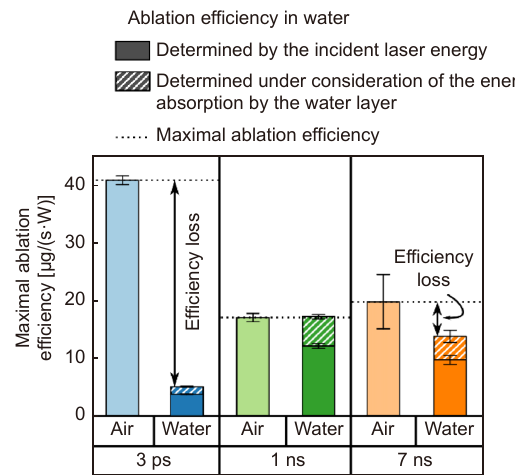
Fig. 2 | Maximal ablation efficiency for the ablation of gold in air (light-colored, solid bars) and water (dark-colored bars) for lasers of 3 ps (blue, ~2 J/cm² and 100 μJ/pulse), 1 ns (green, ~8 J/cm² and 130 μJ/pulse), and 7 ns (orange, ~13 J/cm² and 400 μJ) pulse dura- tion with data from ref. 10 where the ablation efficiency is calculated with the incident laser energy (dark-colored, solid bar) and under consideration of the linear energy extinction by the water layer (dark- colored, hatched bar). The error bars represent the statistical